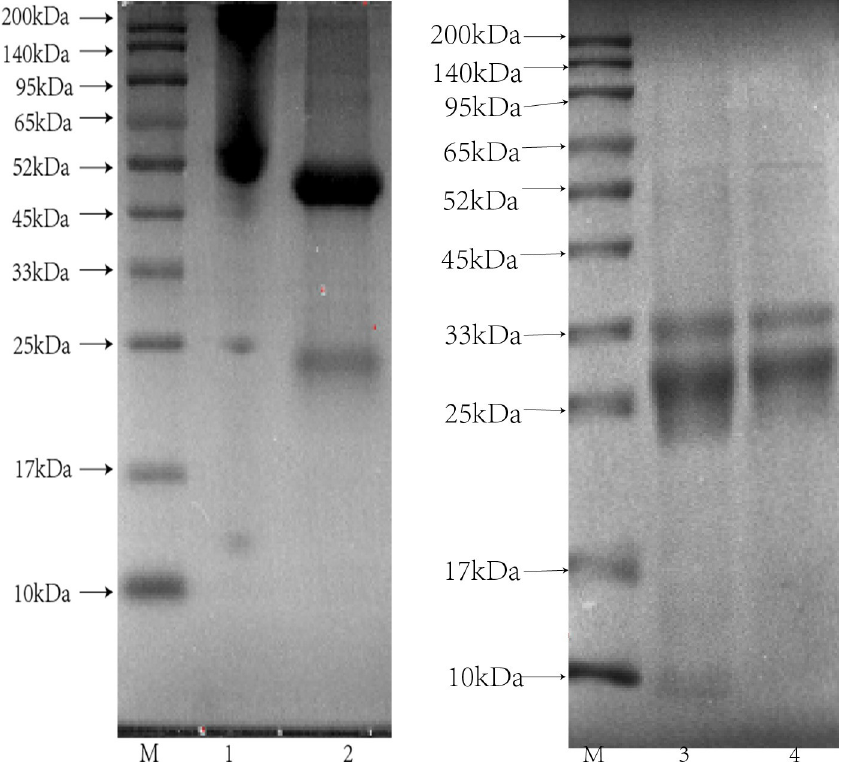
Fig 4. Purity evaluation of affinity purified antibodies. SDS-PAGE (12.5% reducing condition) performed to resolve proteins, and Coomassie staining was used to visualize the resolved bands. M: standard protein marker, lane: 1 and 2 represent rabbit monovalent serum raised against BM venom and its purified antibodies